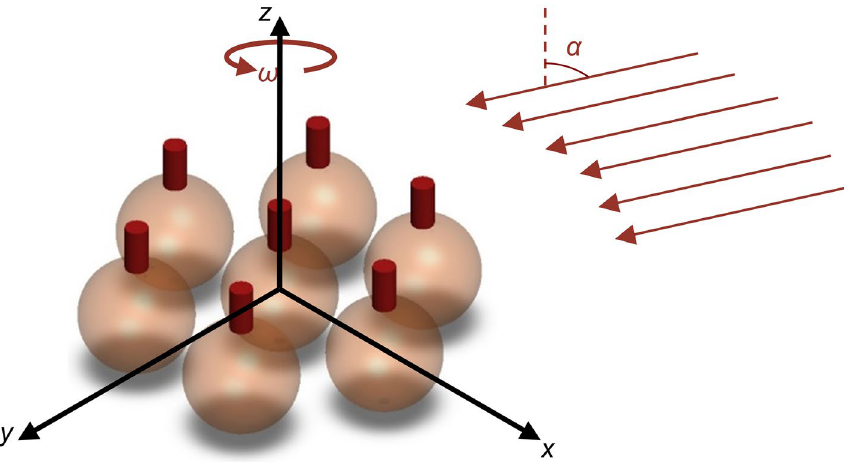
Figure 2. GLAD growth mechanism on sphere seeds. The vapor (arrows) comes with an incident angle of α and deposits on sphere seeds while the substrate rotates at the rate ω